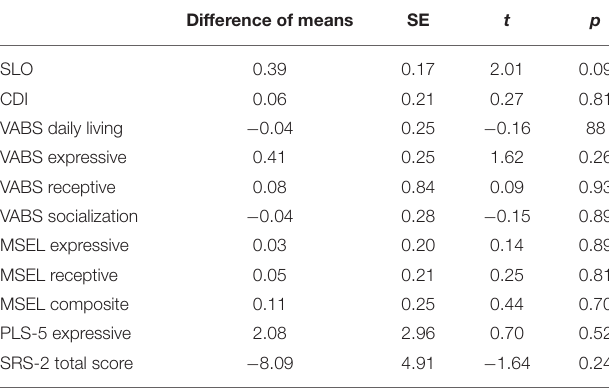
TABLE 4 | Comparison of treatment effectiveness between pivotal response treatment and control